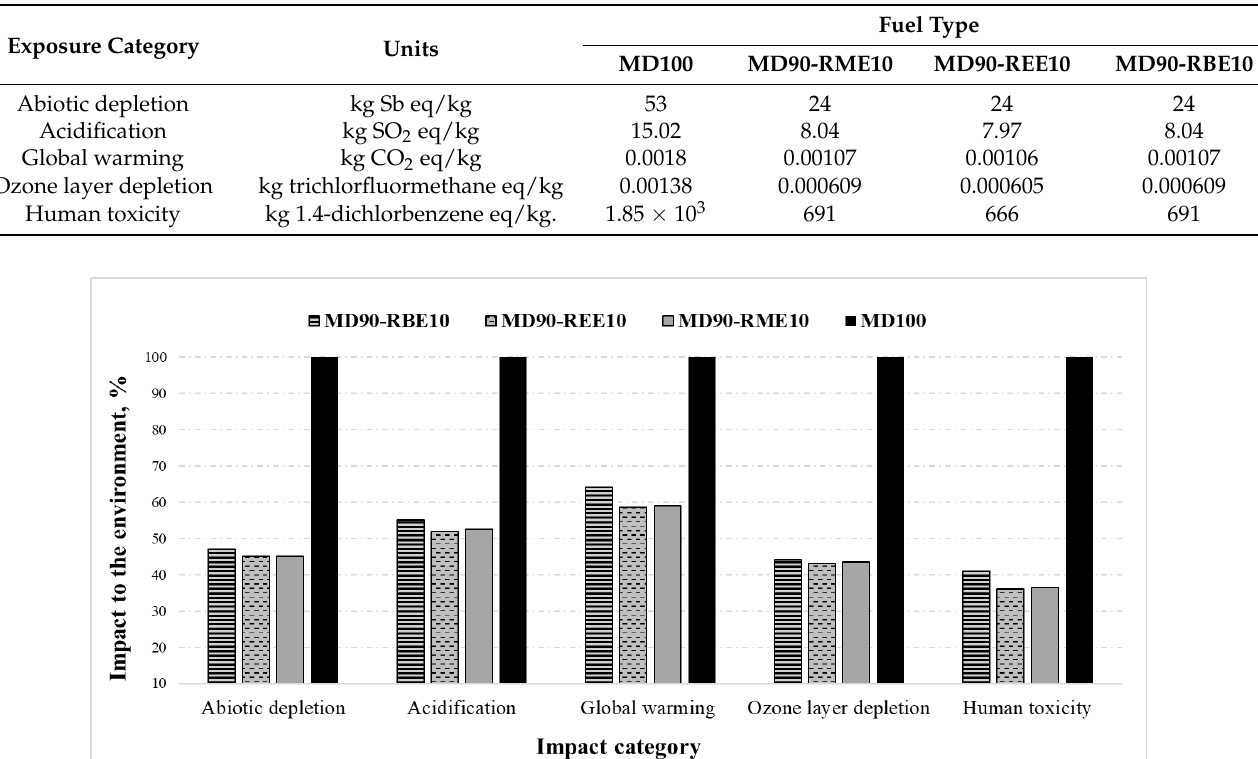
Table 4. Environmental exposure categories determined using the CML-2 baseline 2000 method.